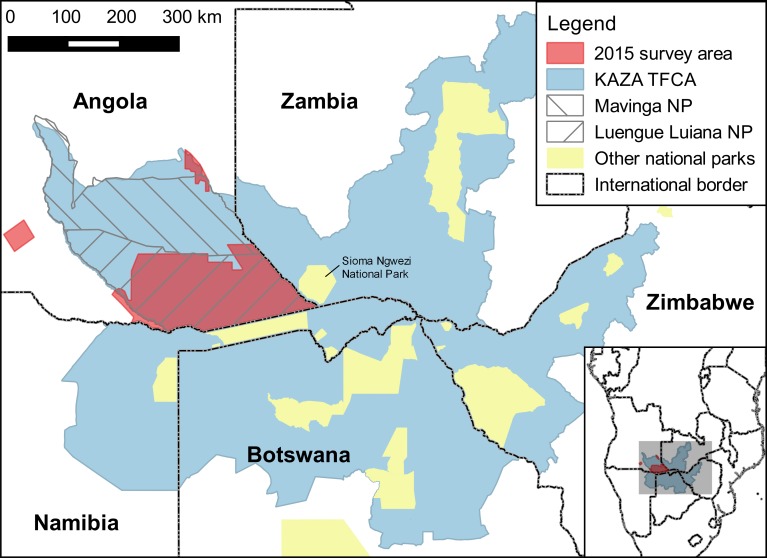
Study area for 2015 aerial surveys in Angola.Also shown are the Mavinga and Luengue Luiana National Parks in Angola, the Kavango-Zambezi Transfrontier Conservation Area (KAZA TFCA), and national parks in other KAZA TFCA countries.